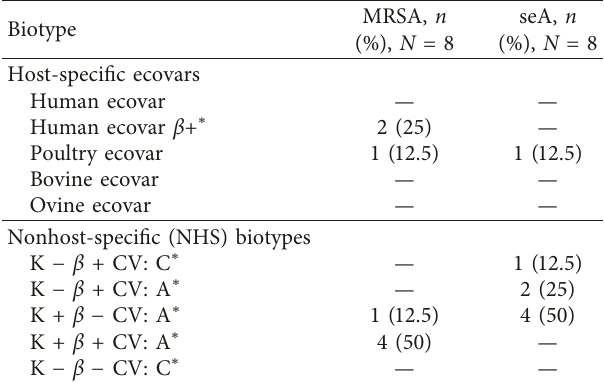
Table 4: Methicillin resistance and enterotoxin A production in S. aureus biotypes.